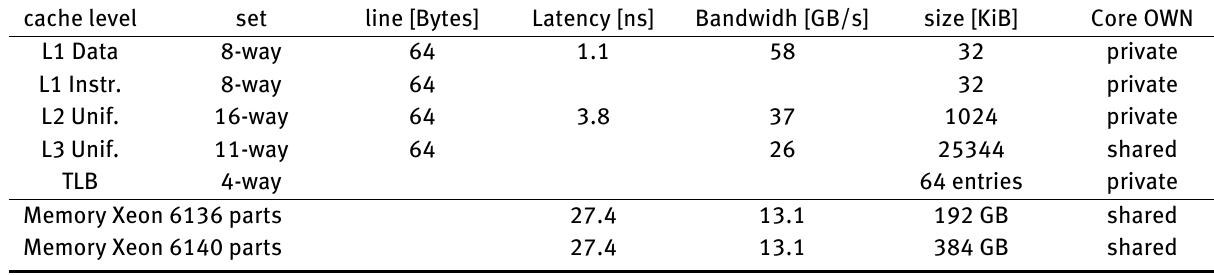
Table 2: Memory properties from Xeon 6136/6140 processor visible from single core cache level